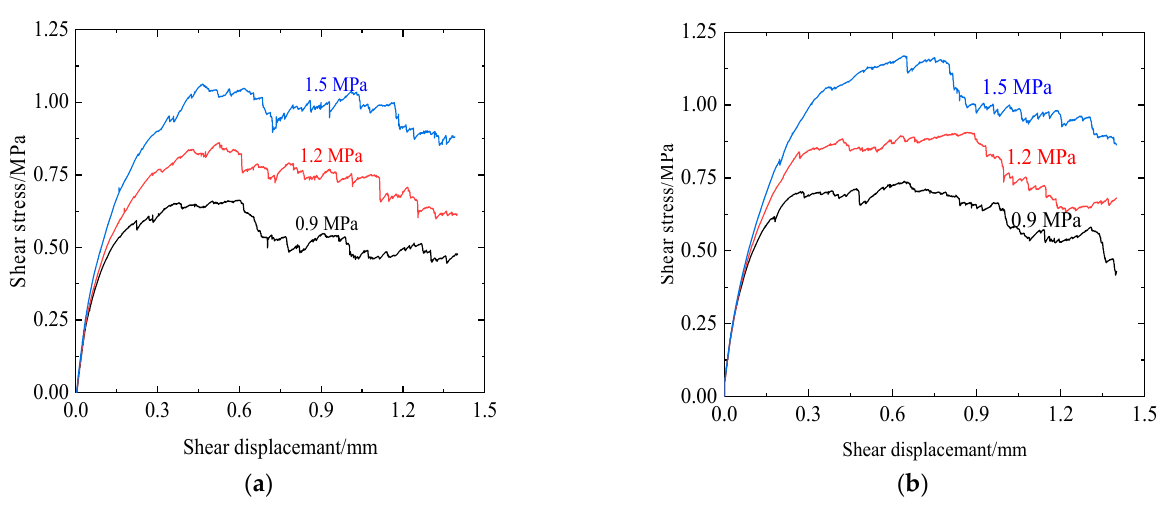
Figure 10. Shear stress–shear displacement curve of simulated direct shear tests on nature gas hydrate deposition under different normal stresses: ( a ) S h = 20%, ( b ) S h = 30%.